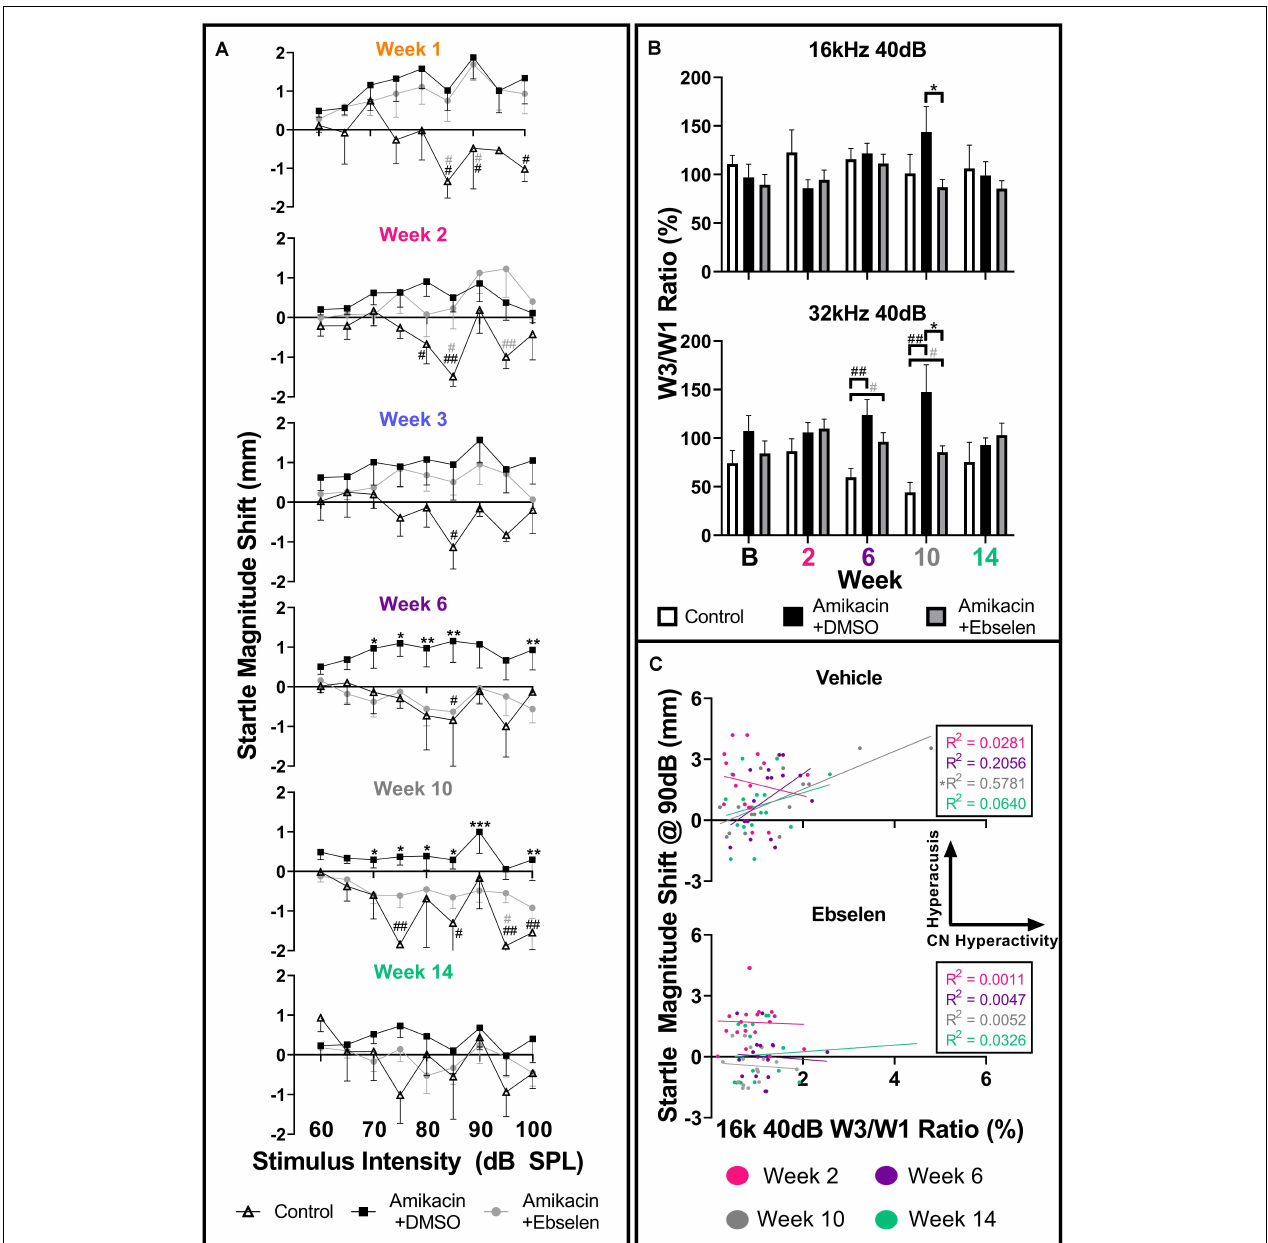
FIGURE 6 | Evaluation and comparison of behavioral evidence of hyperacusis and electrophysiological evidence of increased central gain over time between treatment groups. (A) Averaged IO stimulus/response curves at multiple timepoints (time from the start of treatment {1, 2, 3, 6, 10, 14 weeks} – baseline) showing changes in startle response magnitude CMD (mm) as a function of stimulus intensity (60 to 100 dB SPL). The value 0 on the y-axis represents no change from baseline startle. Note the difference in startle magnitude change between control and amikacin treated mice until week 14. Data show significant effects of ebselen treatment at week 6 and 10 (see Supplementary Table 1 for significance details). (B) Averaged ABR wave III/I amplitude ratios from baseline and multiple timepoints after treatment. (C) A similar linear regression shows the correlation between startle at 90 dB SPL (from A ) and 40 dB SPL W3/W1 amplitude ratios (from B ) increased from week 2 to week 10 for the vehicle group but not the ebselen group. In (A,B) , data are represented by means and standard errors. Post hoc tests determined significant differences between testing groups, which are indicated as follows: #, between control and DMSO treated animals; # (gray), between control and ebselen treated animals; ∗ , between DMSO and ebselen treated